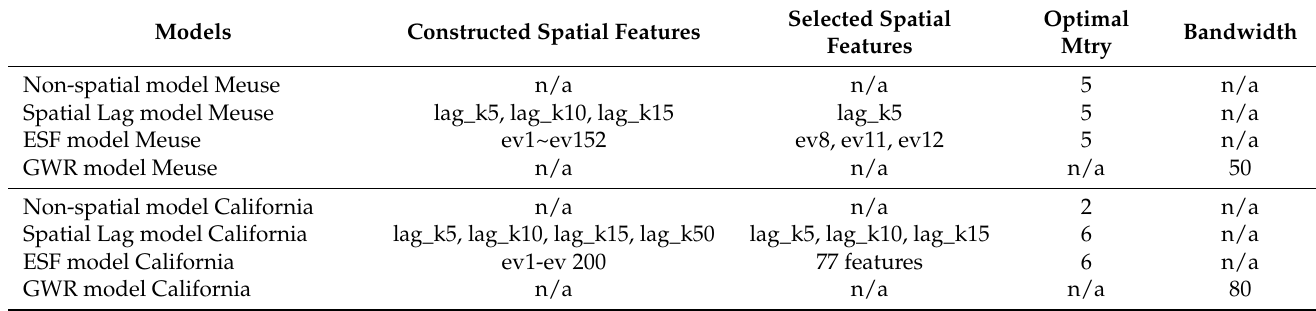
Table 3. Models and their specifications. n/a = not applicable specification for GWR